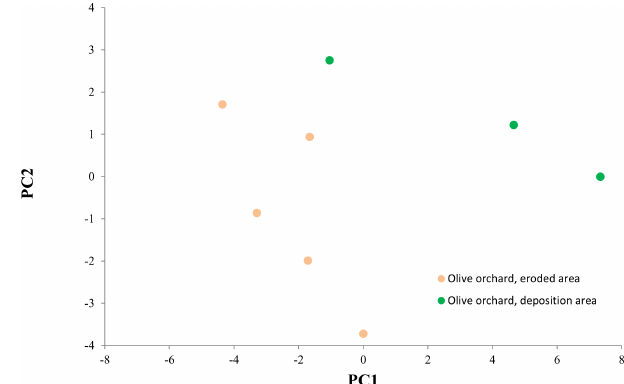
Figure 10. Scores on principal components 1 and 2 (PC 1, PC 2) for sampling points in the eroded and deposition areas in the olive